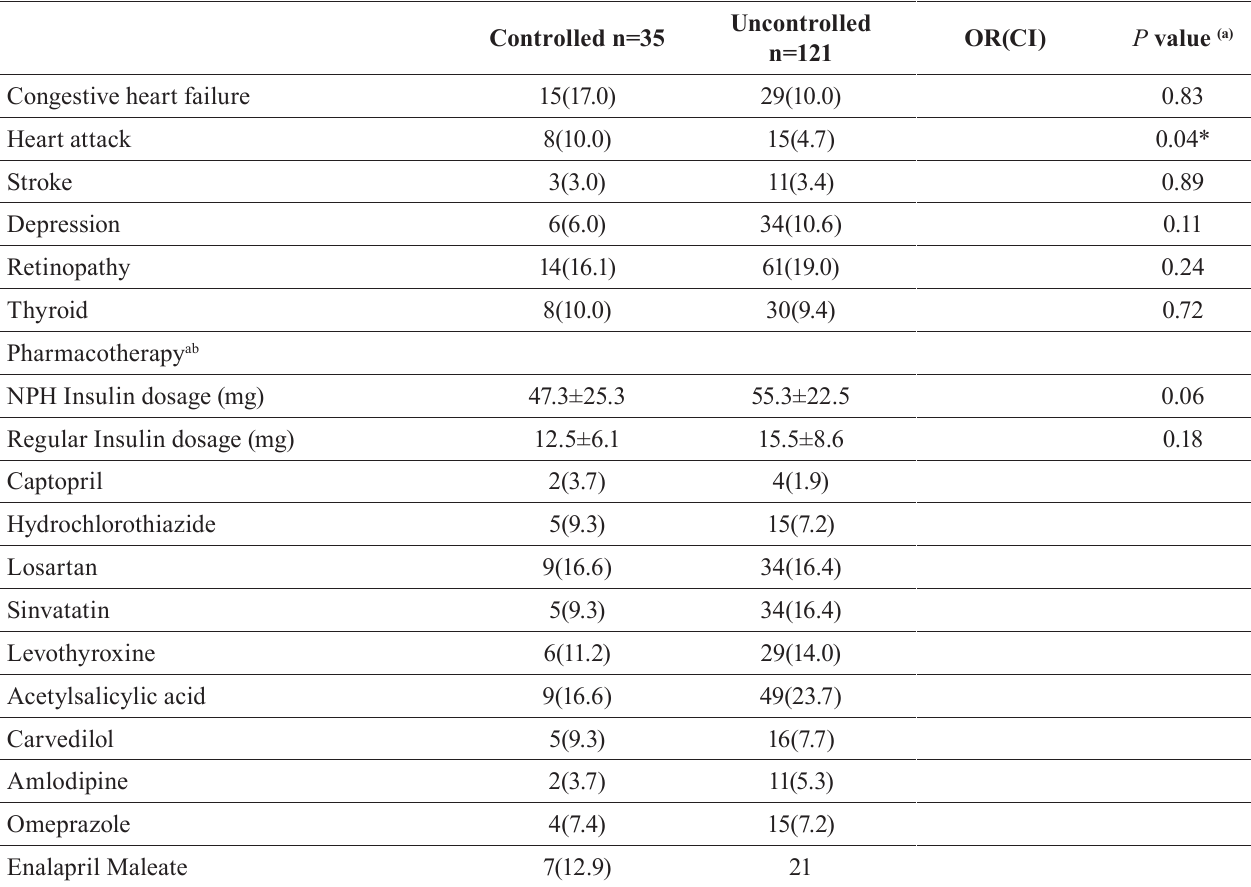
TABLE I - B aseline demographic and clinical characteristics of T1DM patients